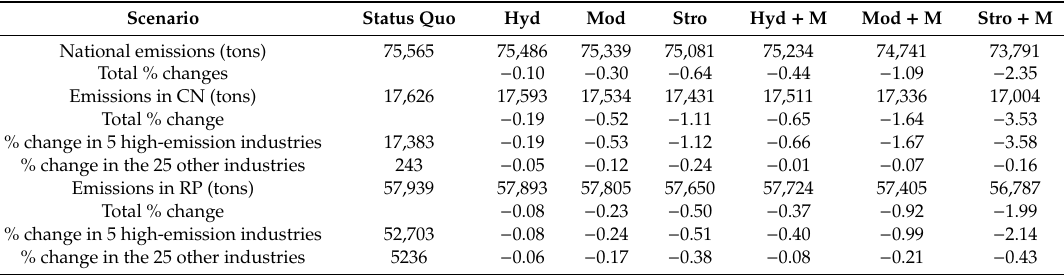
Table 4. Comparison between CN and RP in terms of PM 2.5 emissions under di ff erent